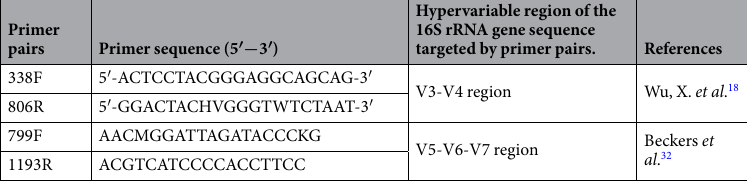
Table 1. Summary of primers used in the current